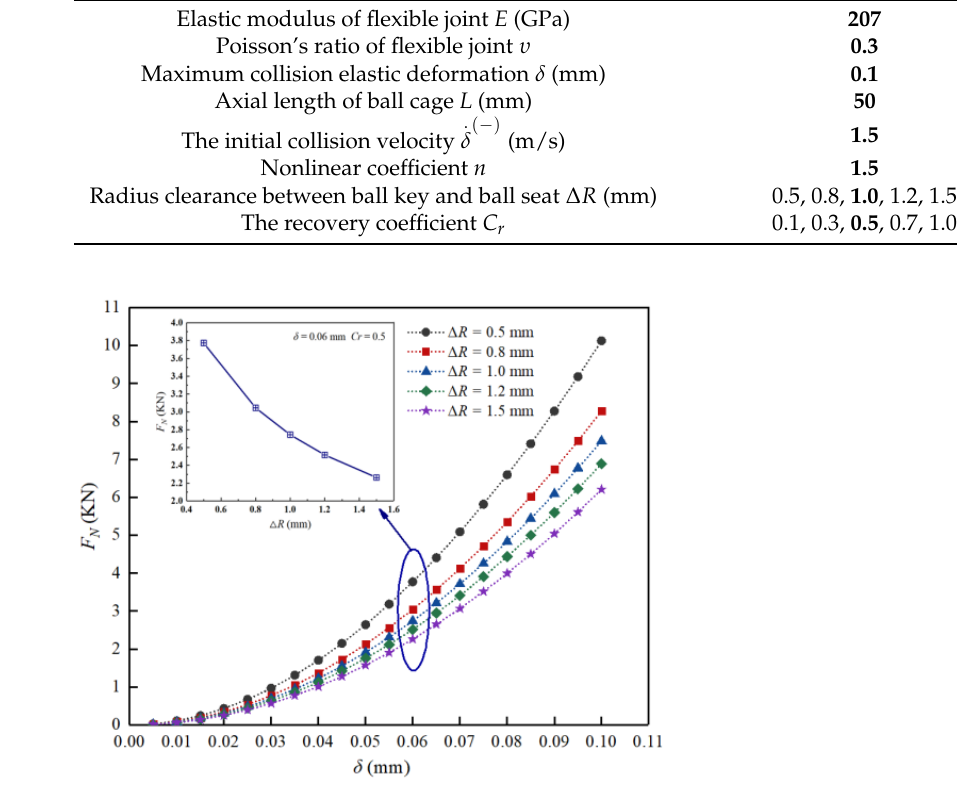
Figure 2. The influence of clearance ∆ R and elastic deformation δ on the normal contact force F N .